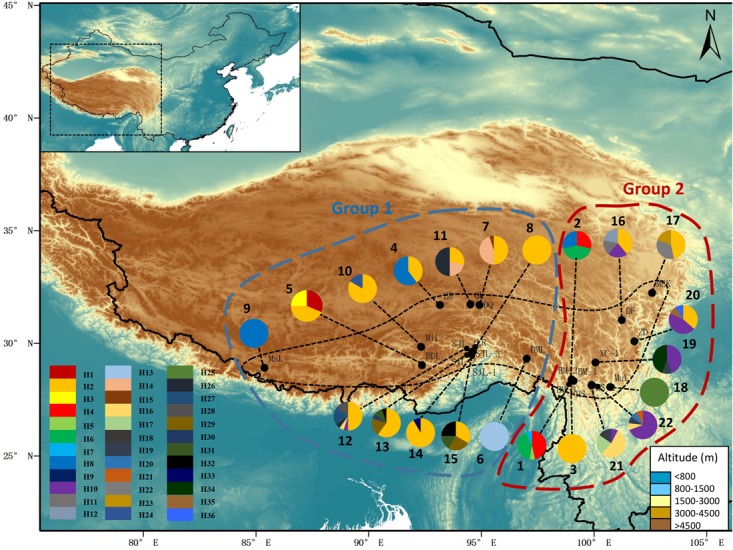
Map showing the sampling localities and the geographic distribution of haplotypes of Rhodiola fastigiata based on the cpDNA dataset. Pie charts show the proportion of haplotypes within each population. The numbers besides the circles represent population number as in Supplementary Table S1. Dashed line on the map indicates the distribution area of R. fastigiata. The two geographic groups defined by the SAMOVA analysis are also indicated by colored dashed lines.